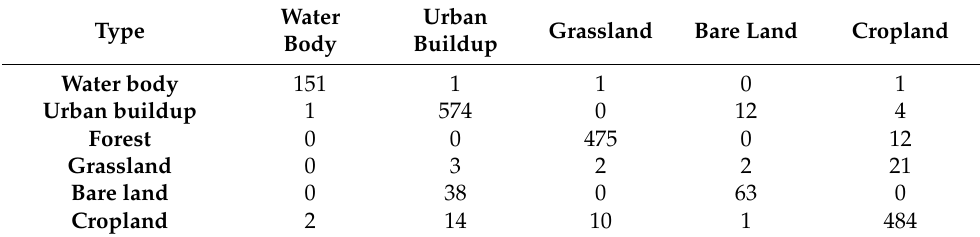
Table 6. Confusion matrix for the land cover map of Beijing in 2019. Water Urban Grassland Bare Land Cropland Type Body Buildup Water